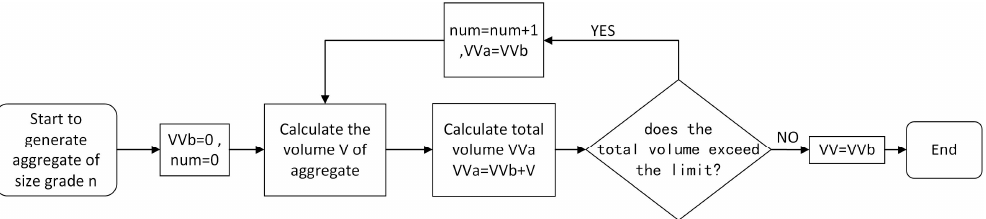
Figure 2. The fl owchart of aggregate